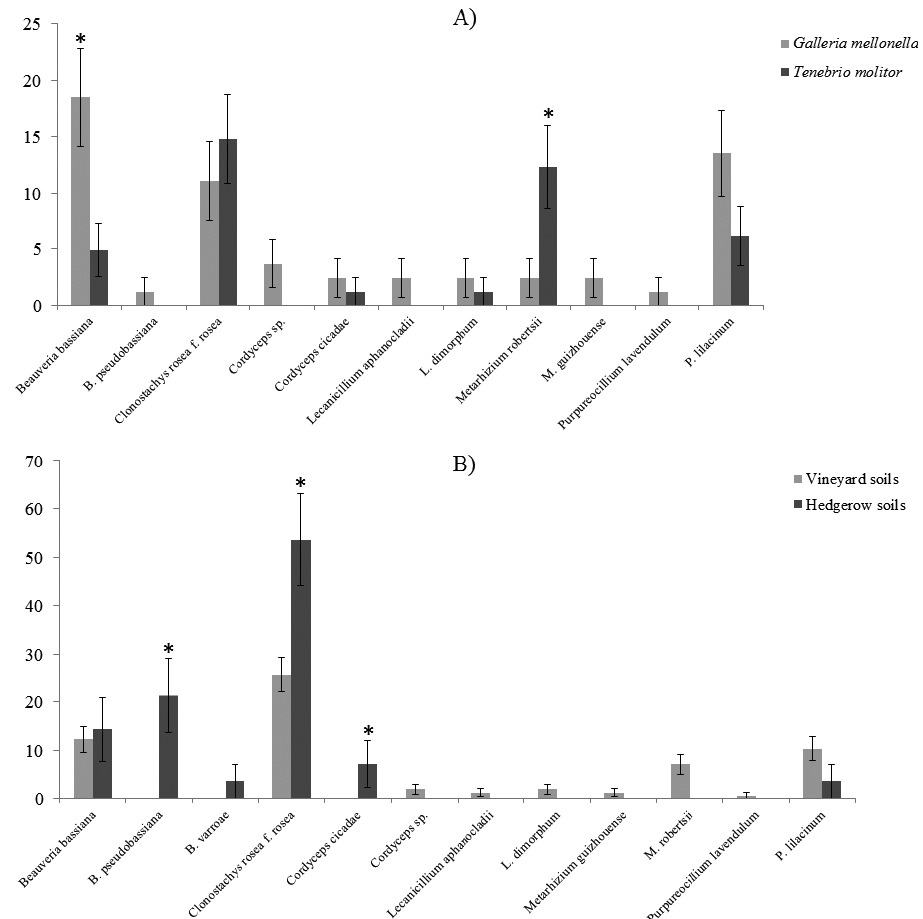
Figure 2. Effect of insect baiting and habitat-type on the isolation of the entomopathogenic fungi. a Occurrence (% of soil samples ± SE) of entomopathogenic fungi when different bait-insects were in- corporated b Occurrence (% of soil samples ± SE) of entomopathogenic fungi when soils were collected from different habitat-types. Bars with asterisk (*) show significant isolations, i.e. ( P